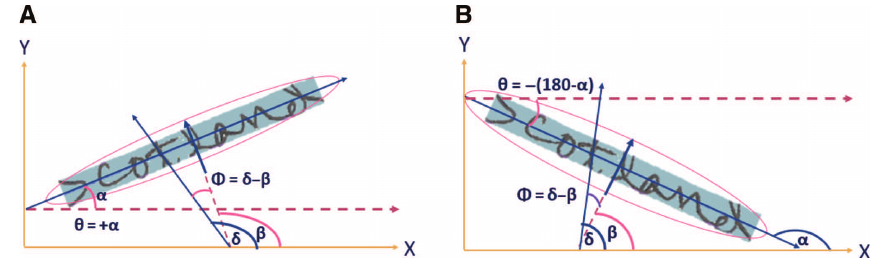
Figure 7: Calculation of Slope Angle ( θ ) and Slant Angle ( ϕ ).